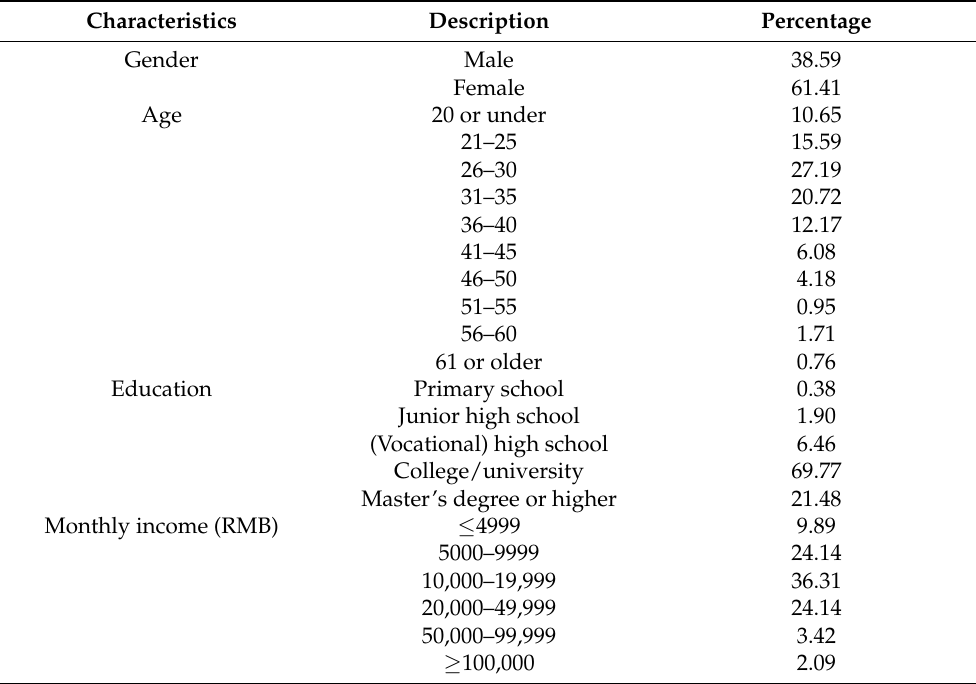
Table 2. Socio-demographic characteristics of respondents.